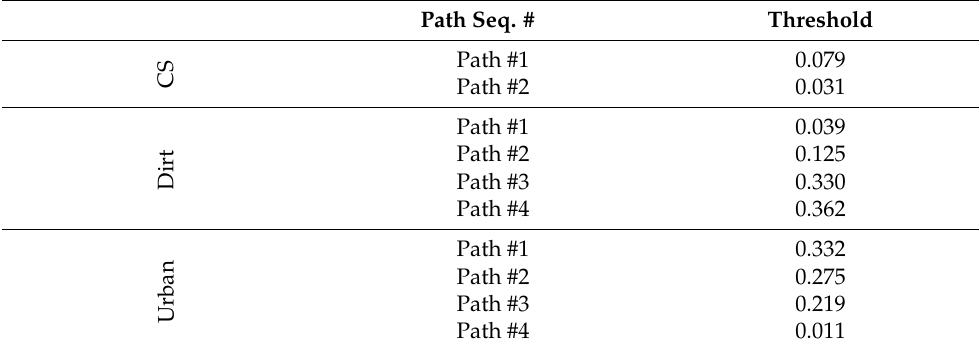
Table 3. Listof automatically learned distance thresholds indicating the presence of anomalies for each path sequence in the dataset.